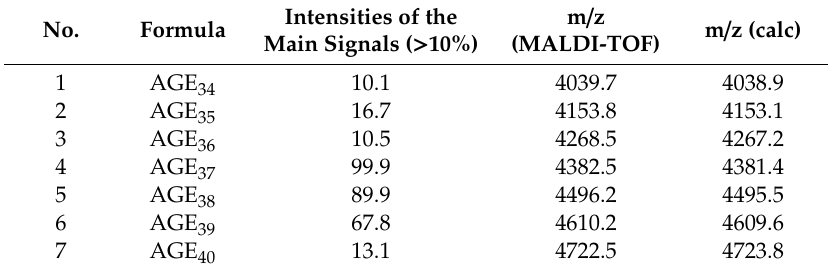
Table 12. PAGE-diols accompanied by AGE / PGE copolymerization initiated with K-DPG /